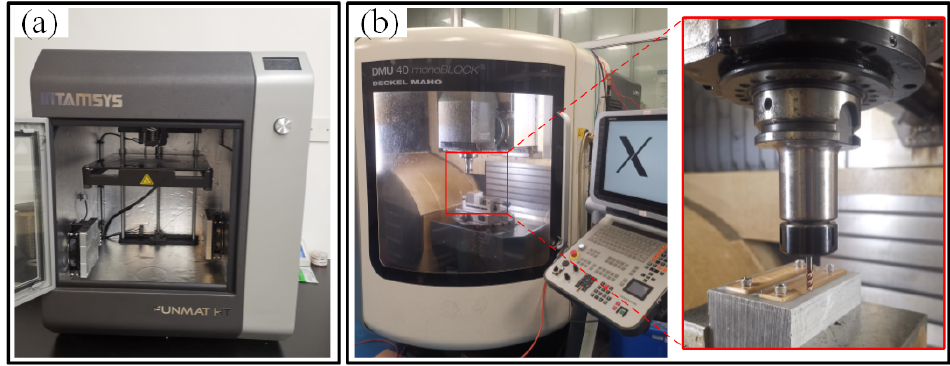
Figure 1. Material handling equipment: ( a ) FUNMAT HT 3D printer; ( b ) DMU40 machining center. Table 1. Material properties of the experimental PEEK and CF/PEEK.